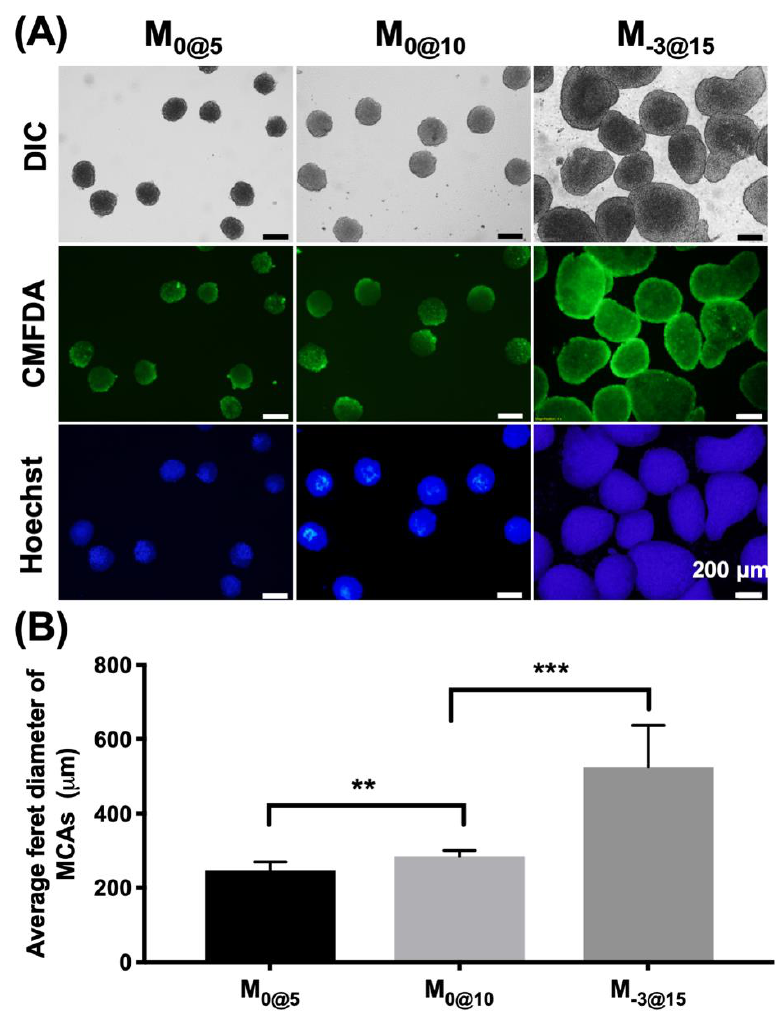
Figure 3. Comparison of multicellular cancer aggregates (MCAs) formed in different microwell conditions. ( A ) The images of the morphology of the MCAs formed in different microwells. ( B ) The average Feret diameter was measured for the MCAs formed in each type of microwell.